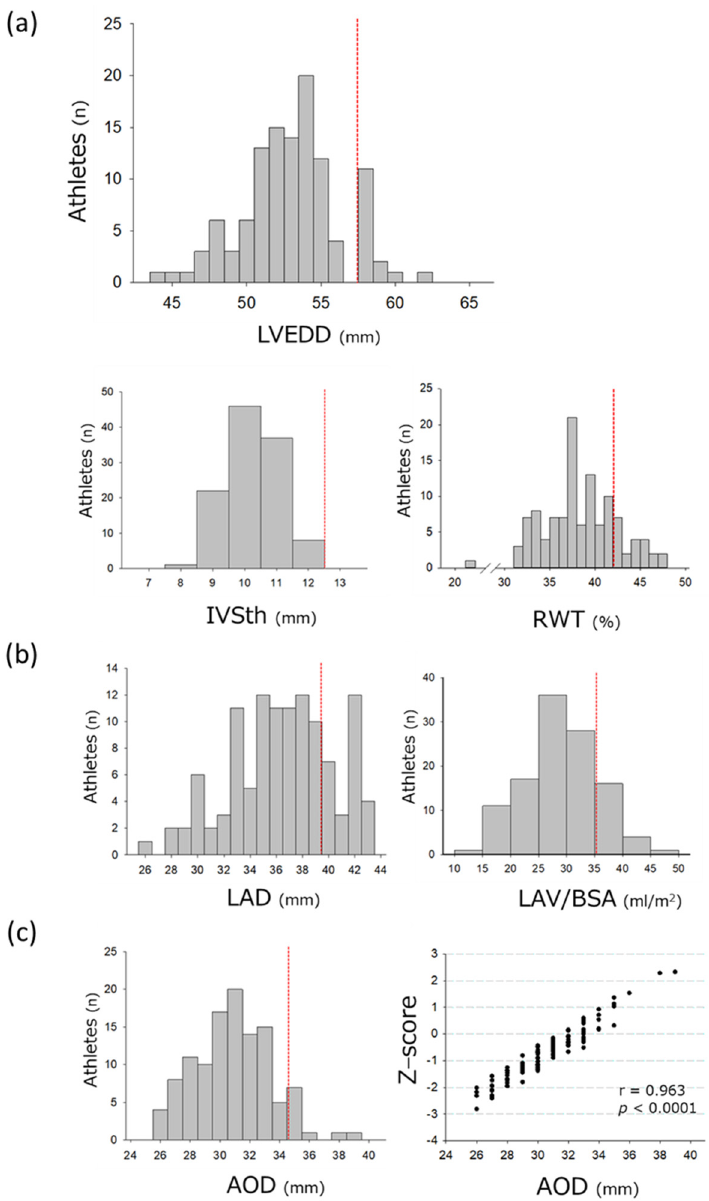
Figure 1. Distributions of dimensions and wall thicknesses of the left heart in young Japanese rugby athletes. Distributions are shown for the ( a ) left ventricle, ( b ) left atria, and ( c ) aorta. Red dotted lines signify the normal upper limit of the general population, according to the guidelines [10]. AOD, aortic root dimension; BSA, body surface area; IVSth, thickness of interventricular septum; LAD, left atrial dimension; LVEDD, left ventricular end − diastolic dimension; RWT, relative wall thickness The echocardiographic parameters were compared between the two player types (Table 3). The absolute values of LVEDD, PWth, LDEDV, LVESV, and LVM were signifi- cantly larger in the forwards than in the backs, whereas LVEDD/BSA and LVESD/BSA were significantly larger in the backs than in the forwards. The indexed LVEDV, LVESV, and LVM did not differ between the two groups. All athletes exhibited normal LV ejection fraction, E/A, and E/e’ (Table 3) without asynergy. The parameters of LV systolic and diastolic function and GLS were not different between the forwards and backs.